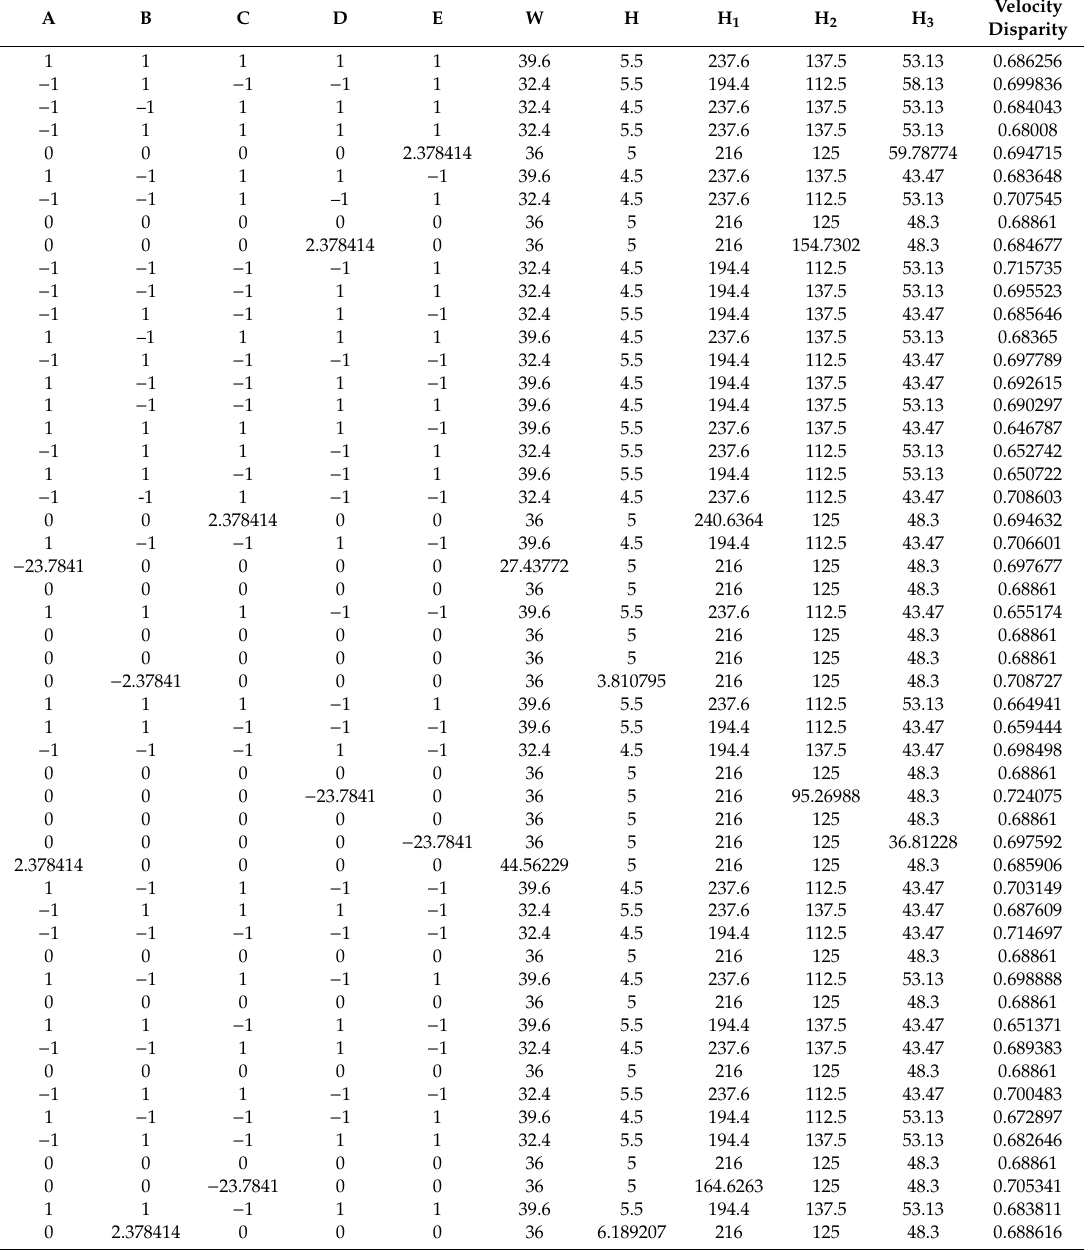
Table 4. Design of experiment and simulation